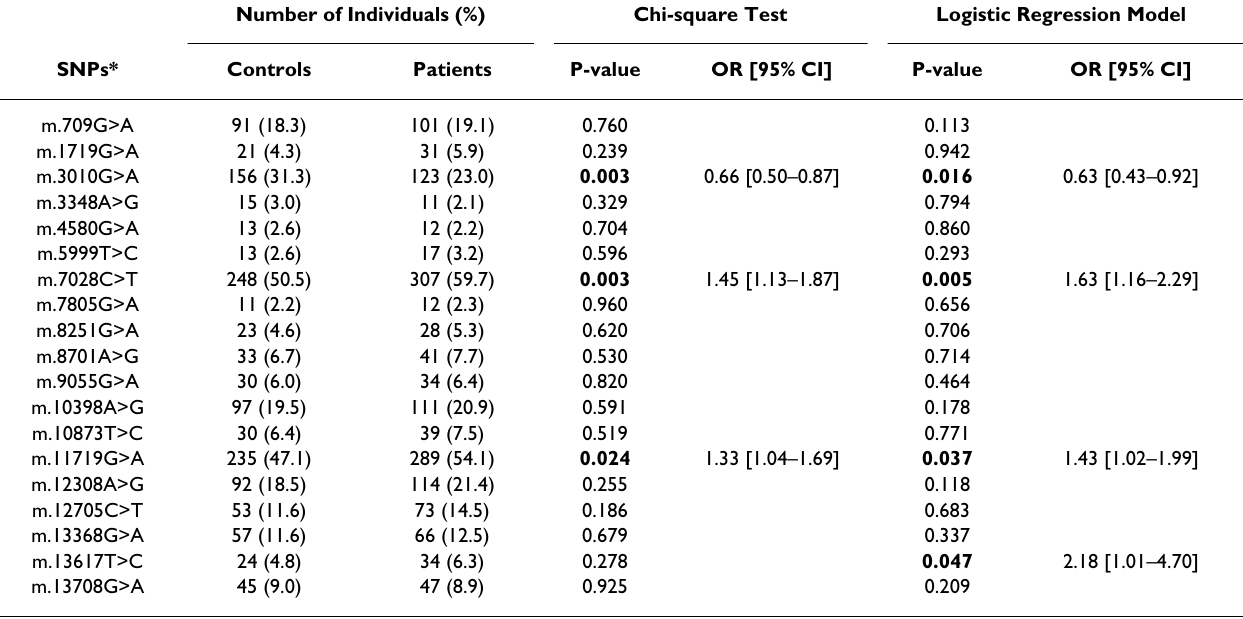
Table 4: Results of mitochondrial SNP association testing with ischemic stroke risk. Significant uncorrected P-values (< 0.05) are highlighted in bold. Crude and adjusted odds ratios (OR) and 95% confidence intervals (CI) are shown only for significantly associated